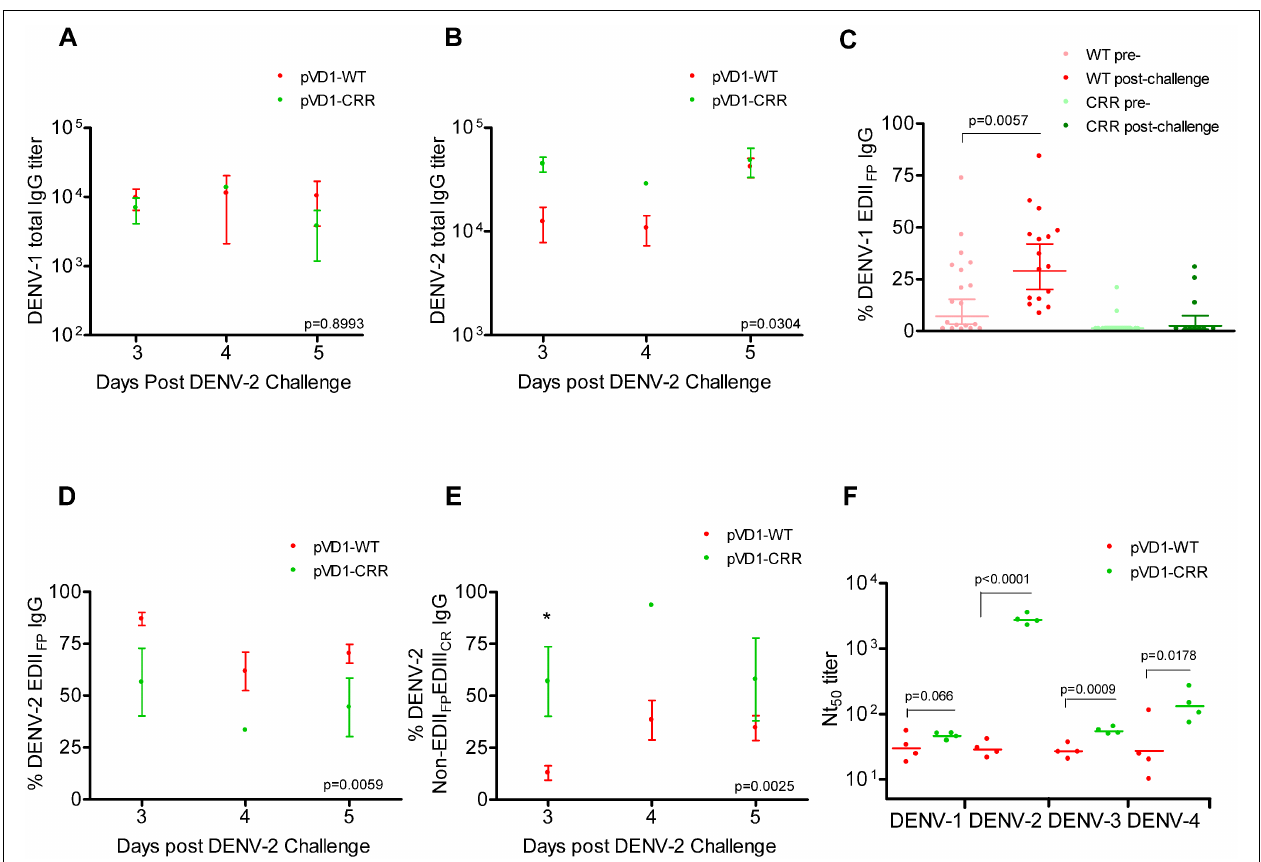
FIGURE 5 | DENV-1 CRR vaccination sculpts immunity to redirect secondary immunity to heterologous dengue infection. AG129 mice were immunized (i.m.) with 100 μ g of pVD1-WT or pVD1-CRR vaccines and challenged at 12 weeks with heterologous DENV-2 S221 (4.2x10 5 FFU, i.p.). Arithmetic means and SEM are depicted in A, B, D, and E and analyzed with two-way ANOVA. Bonferroni post hoc test significance is depicted with asterisks. (A) DENV-1 total IgG endpoint titers of pVD1-WT and -CRR immunized mice 3, 4, and 5 DPC with DENV-2.Three, 4, and 5 DPC n = 4, 3, and 8 and 4, 1, and 3 forWT and CRR vaccines respectively. (B) DENV-2 total IgG endpoint titers of pVD1-WT and -CRR vaccinated mice. (C) Percent DENV-1 epitope-specific responses pre- and post-challenge for IgG recognizing immunodominant cross-reactive EDII FP epitopes. pVD1-WT immunized mice had larger populations of EDII FP post DENV-2 challenge than did pVD1-CRR immunized mice (ave = 35.5 and 7.65%, respectively,